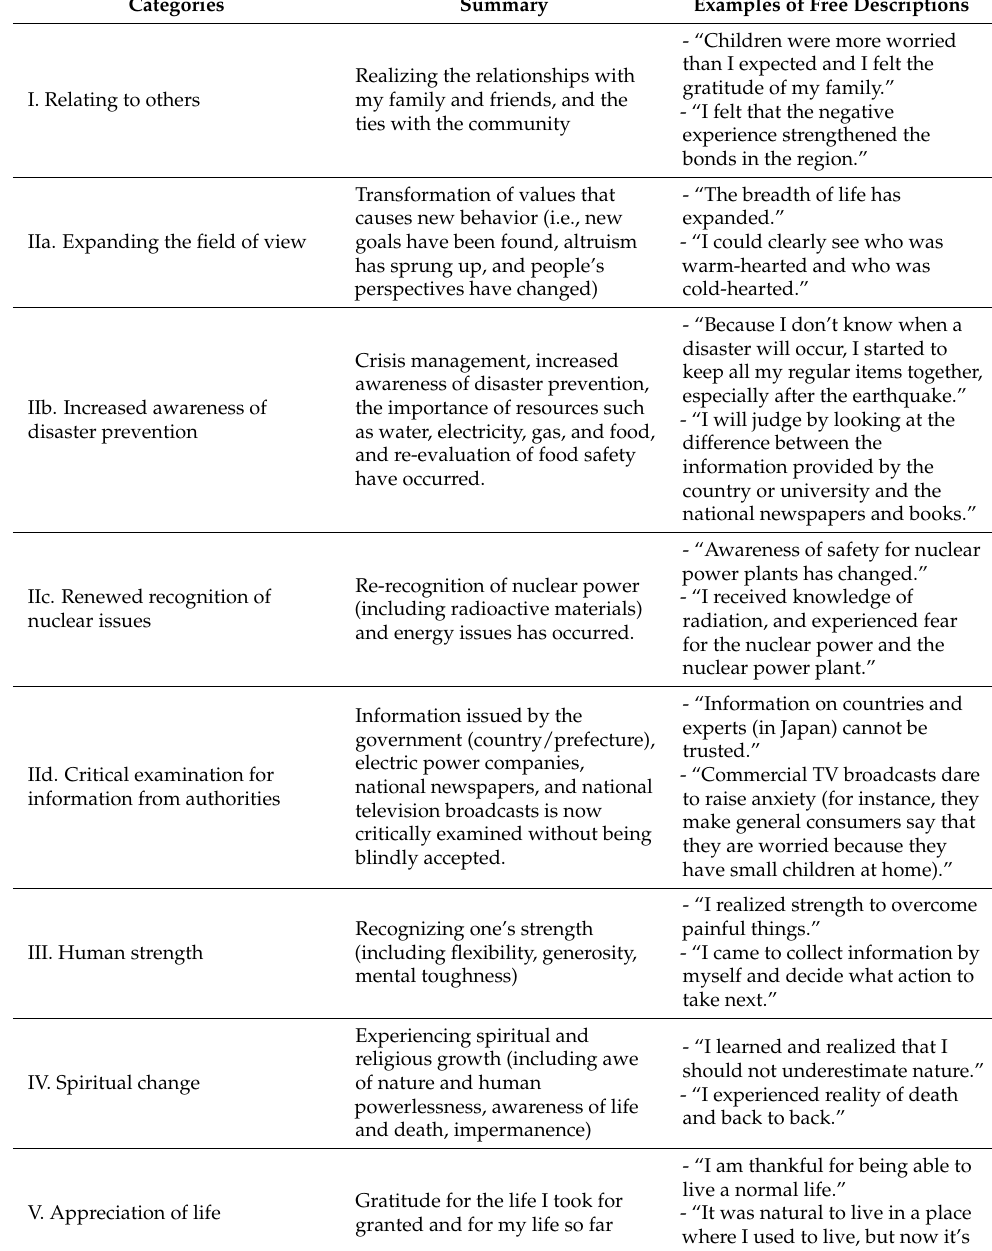
Table 2. Categories for PTG free